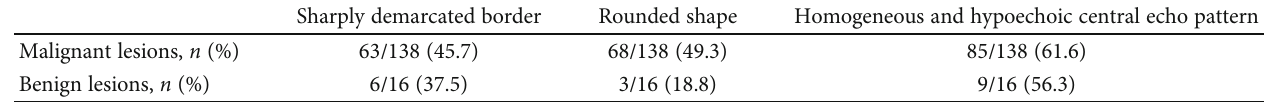
Table 3: EUS fi ndings on malignant and benign lymphadenopathy.